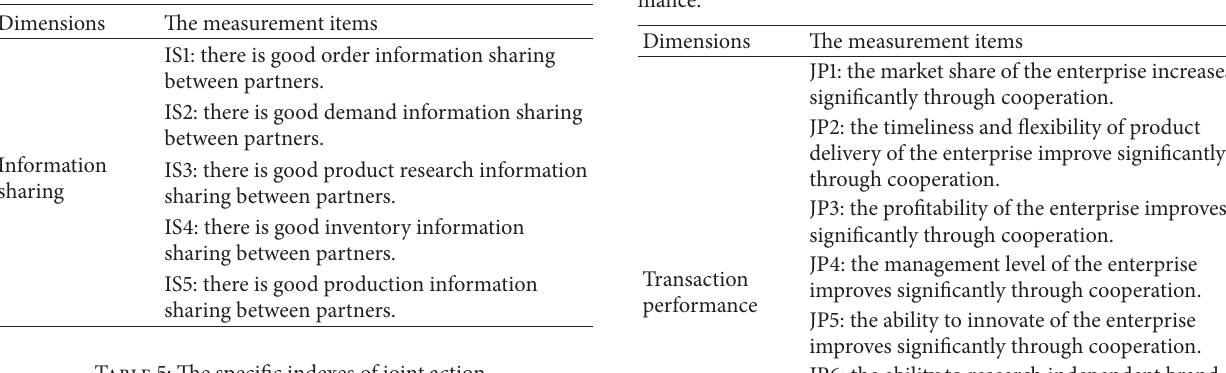
Table 5: The specific indexes of joint action. Dimensions